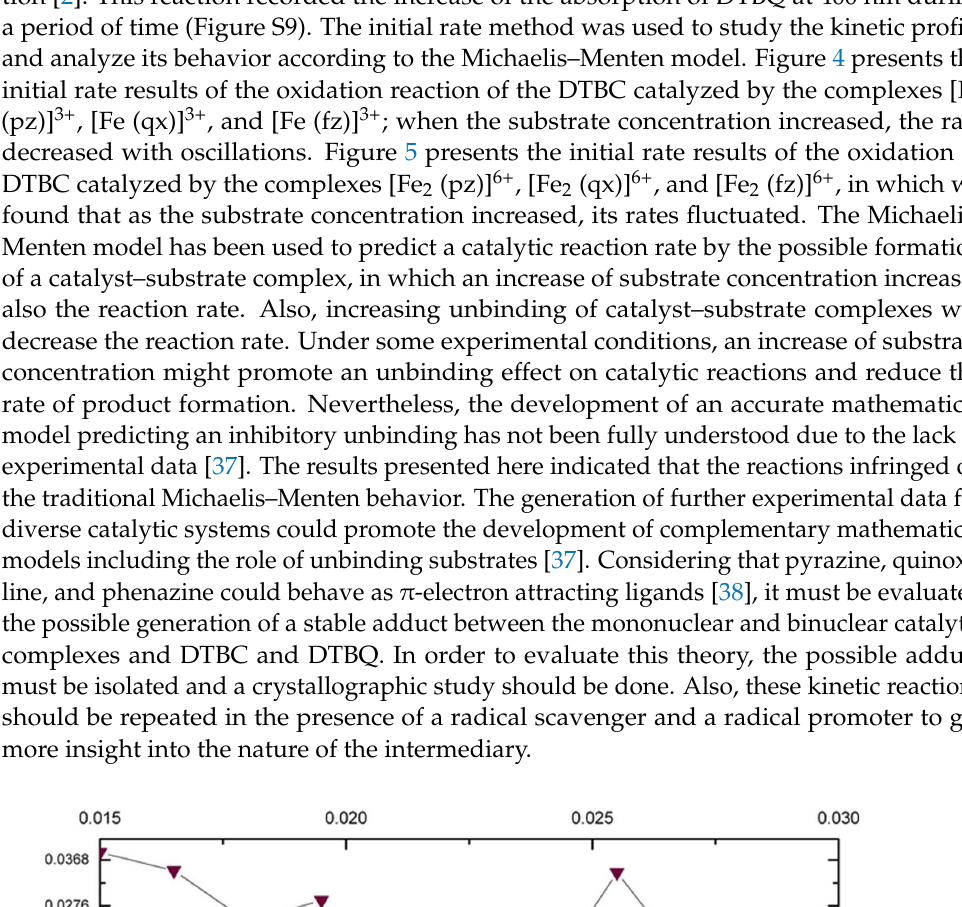
Figure 5. Initial rate results on the oxidation reaction of DTBC to DTBQ and catalyzed by [Fe 2 (pz)] 6+ , [Fe 2 (qx)] 6+ , and [Fe 2 (fz)] 6+ .